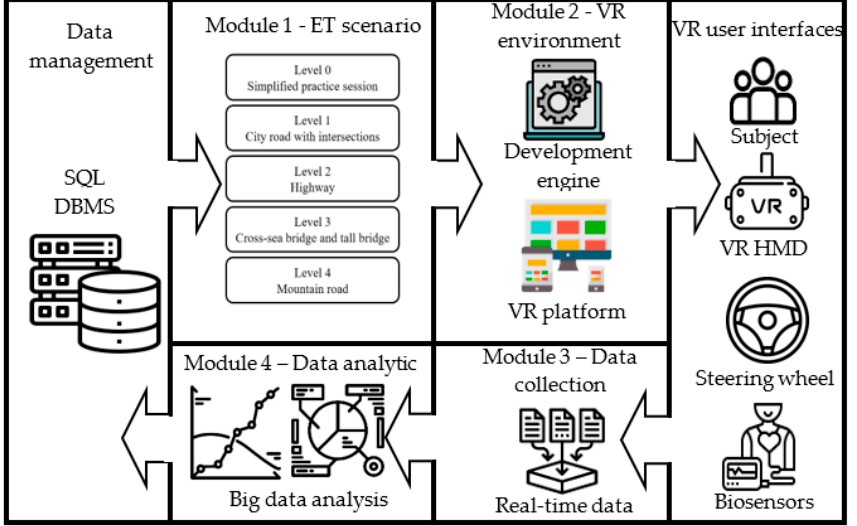
Figure 6. The driving phobia VRET system framework.